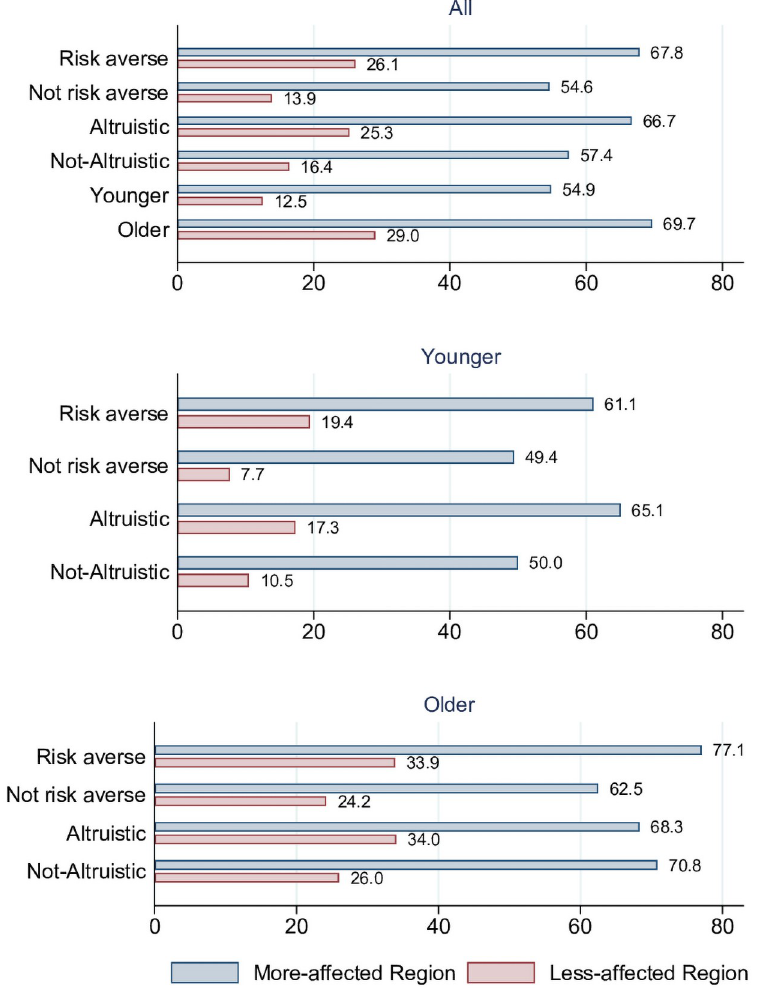
Fig 2. Descriptive statistics on mask wearing in percent. Risk aversion and altruism are binary variables standardized at median. “Younger” refers to up to 44 years of age and “Older” refers to 45 years of age and older.